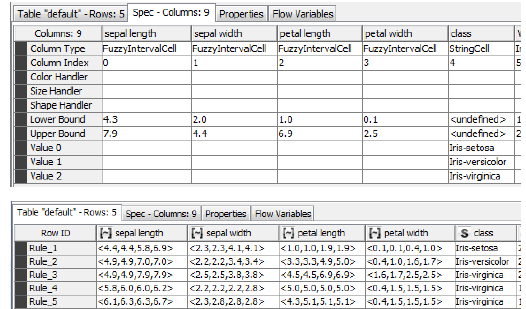
Fig. 10. The output of the fuzzy c-means clustering node, here using the bar renderer to display the degrees of mem-